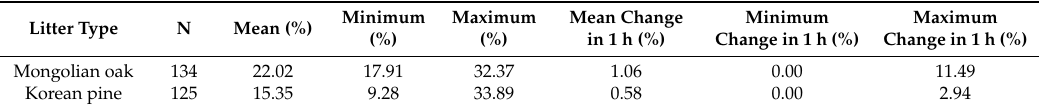
Table 2. Basic statistics of the moisture content of surface litter.